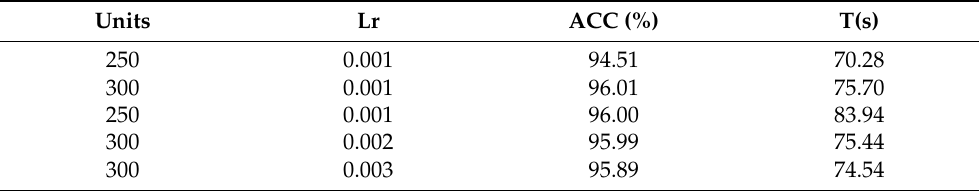
Table 2. Model parameter